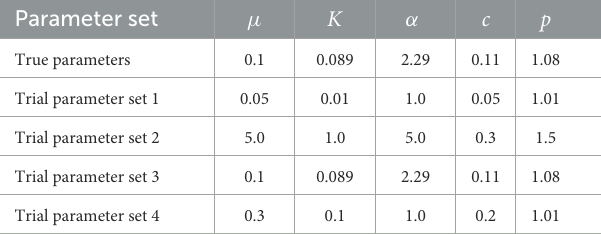
by practitioners. However, we will be explicit in exploring the implications of this choice.